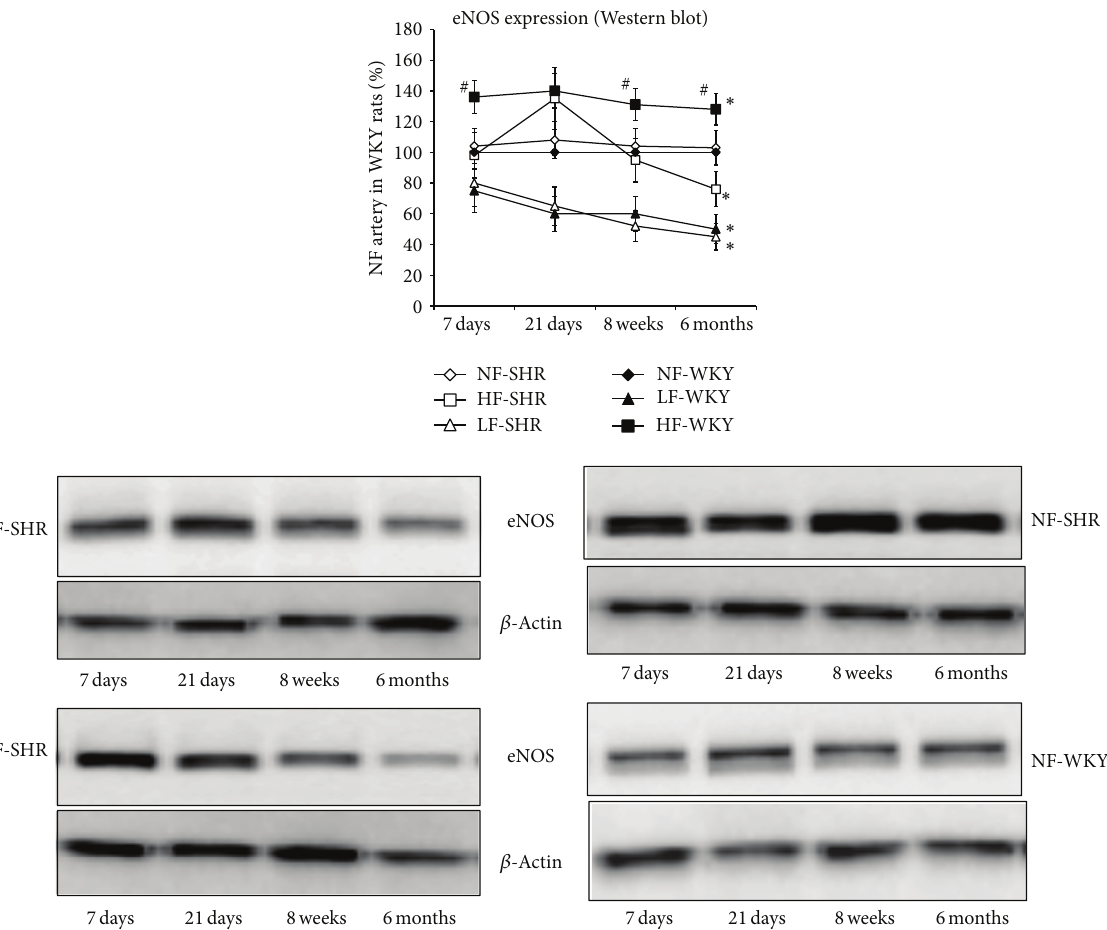
Figure 5: Endothelial NO synthase (eNOS) expression level was determined using western blot in mesenteric resistance arteries isolated from WKY rats and SHRs submitted to low flow (LF), high flow (HF), or normal flow (NF) for 1, 3, 8, or 24 weeks. Values represent mean ± SEM ( 𝑛 = 12 rats per group). ∗ 𝑃 < 0.01 , HF or LF versus NF arteries. # 𝑃 < 0.05 , SHRs versus WKY rats, within equivalent arteries (NF, LF, or